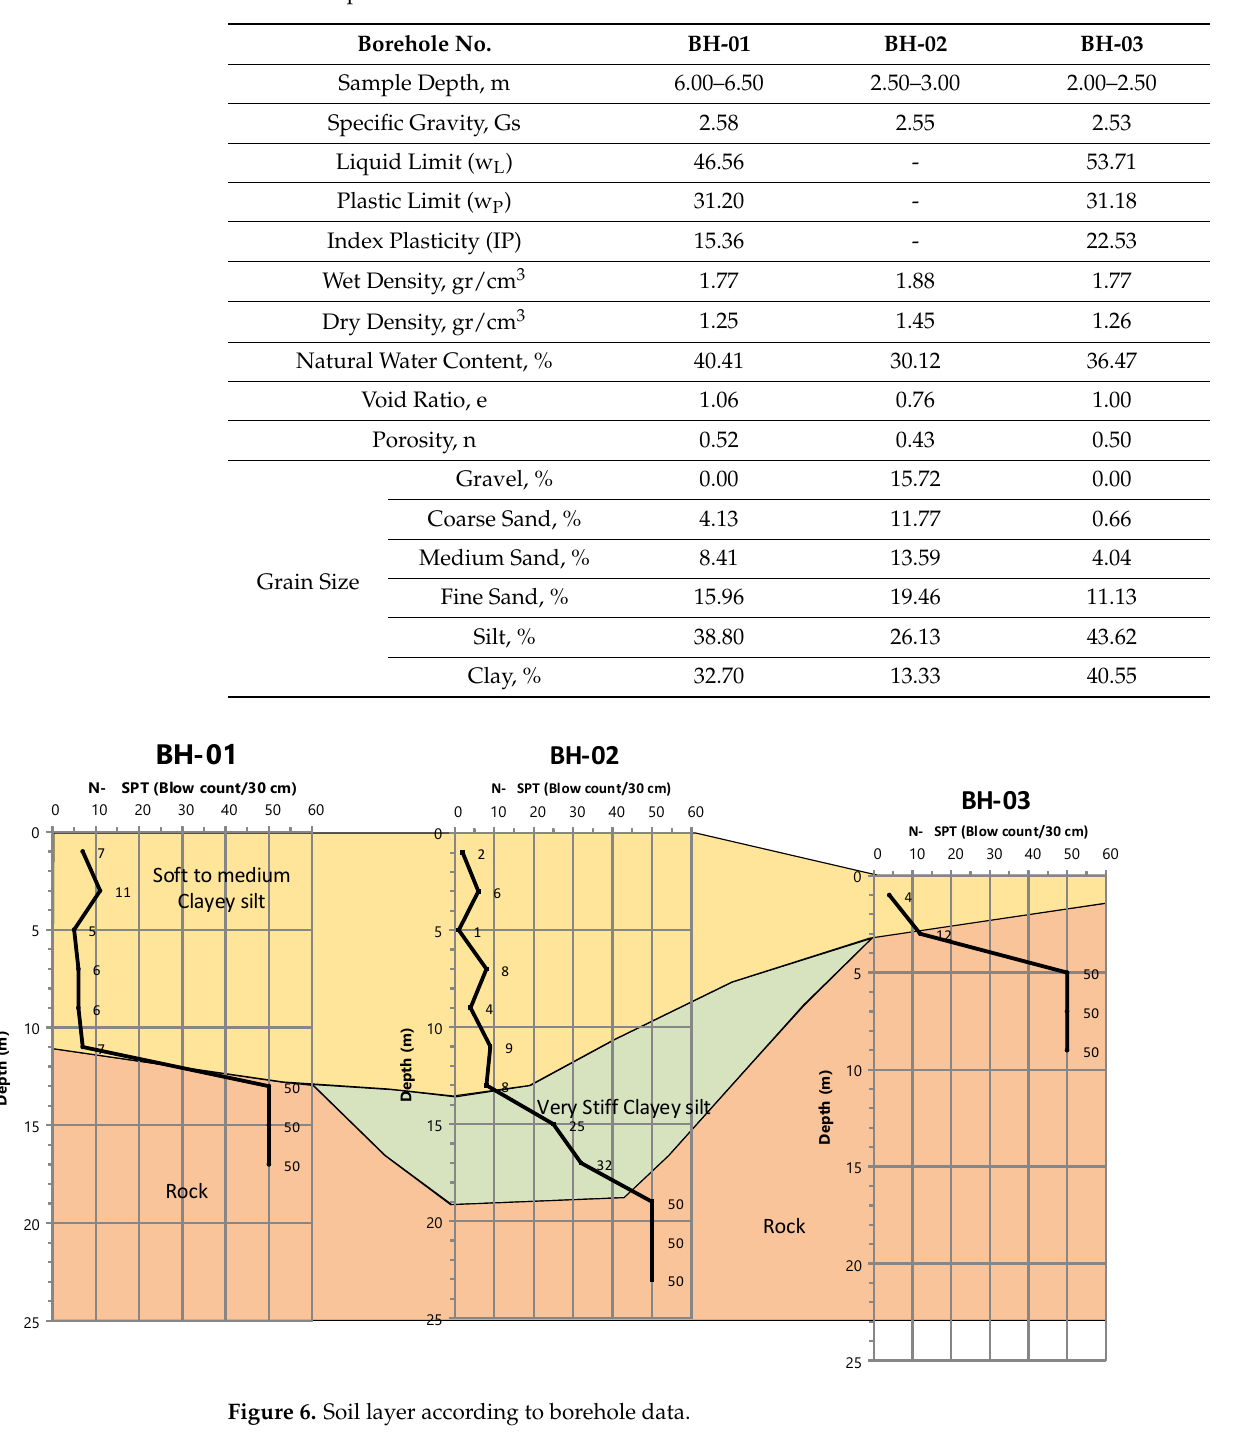
Table 2. Properties of soils.